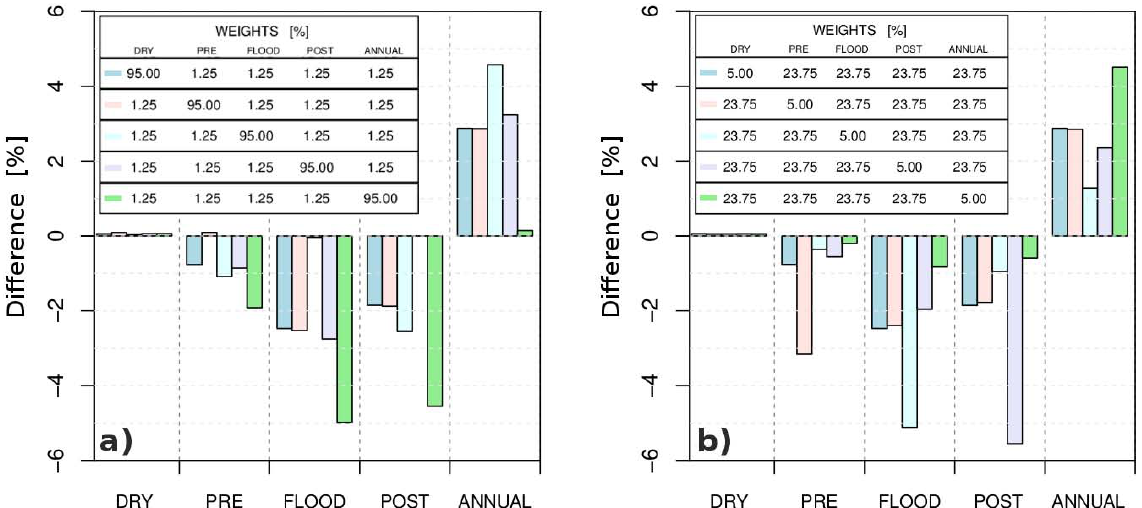
Fig. 4. Differences in percentage between the 100-yr peak flows estimated jointly (proposed technique) and the ones estimated by maximum likelihood independently on each season and on the maximum annual values. (a) Prevailing weight (95%) to one given period and 1.25% to the other distributions; (b) small weight (5%) to one given period and 23.75% to the other